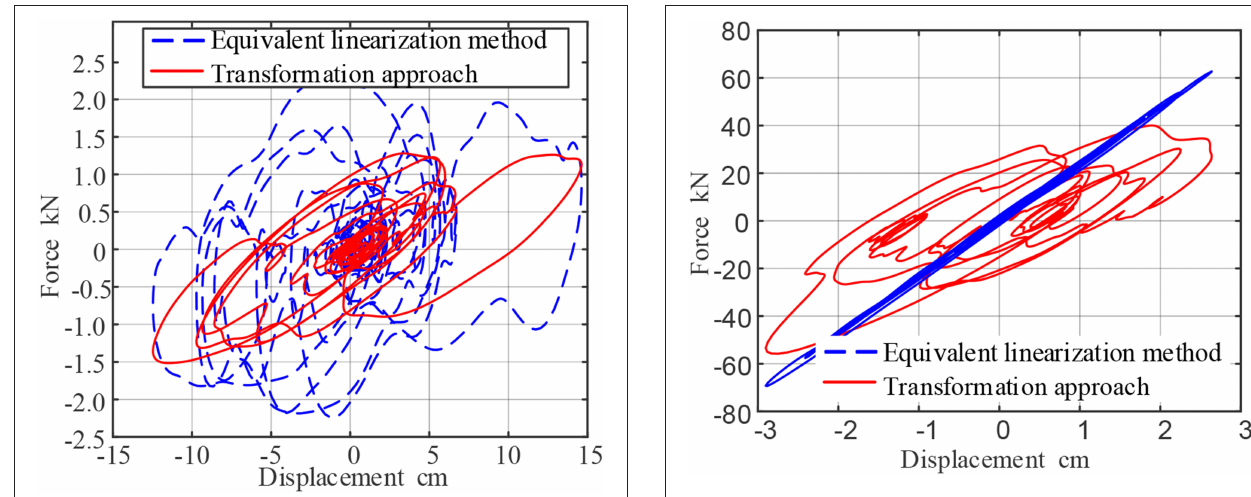
Same as El Centro earthquake, the force-displacement curve under Taft earthquake can also be found that the hysteresis loop of the equivalent linearization method is not full, and the